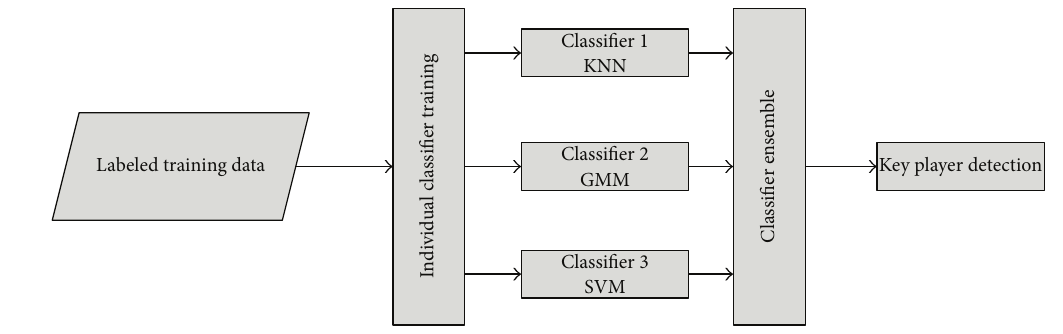
Figure 4: Proposed framework for hybrid